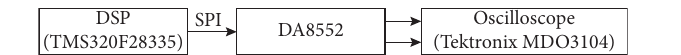
Figure 3: Working principle for implementing the Chua system with hidden attractors on DSP.